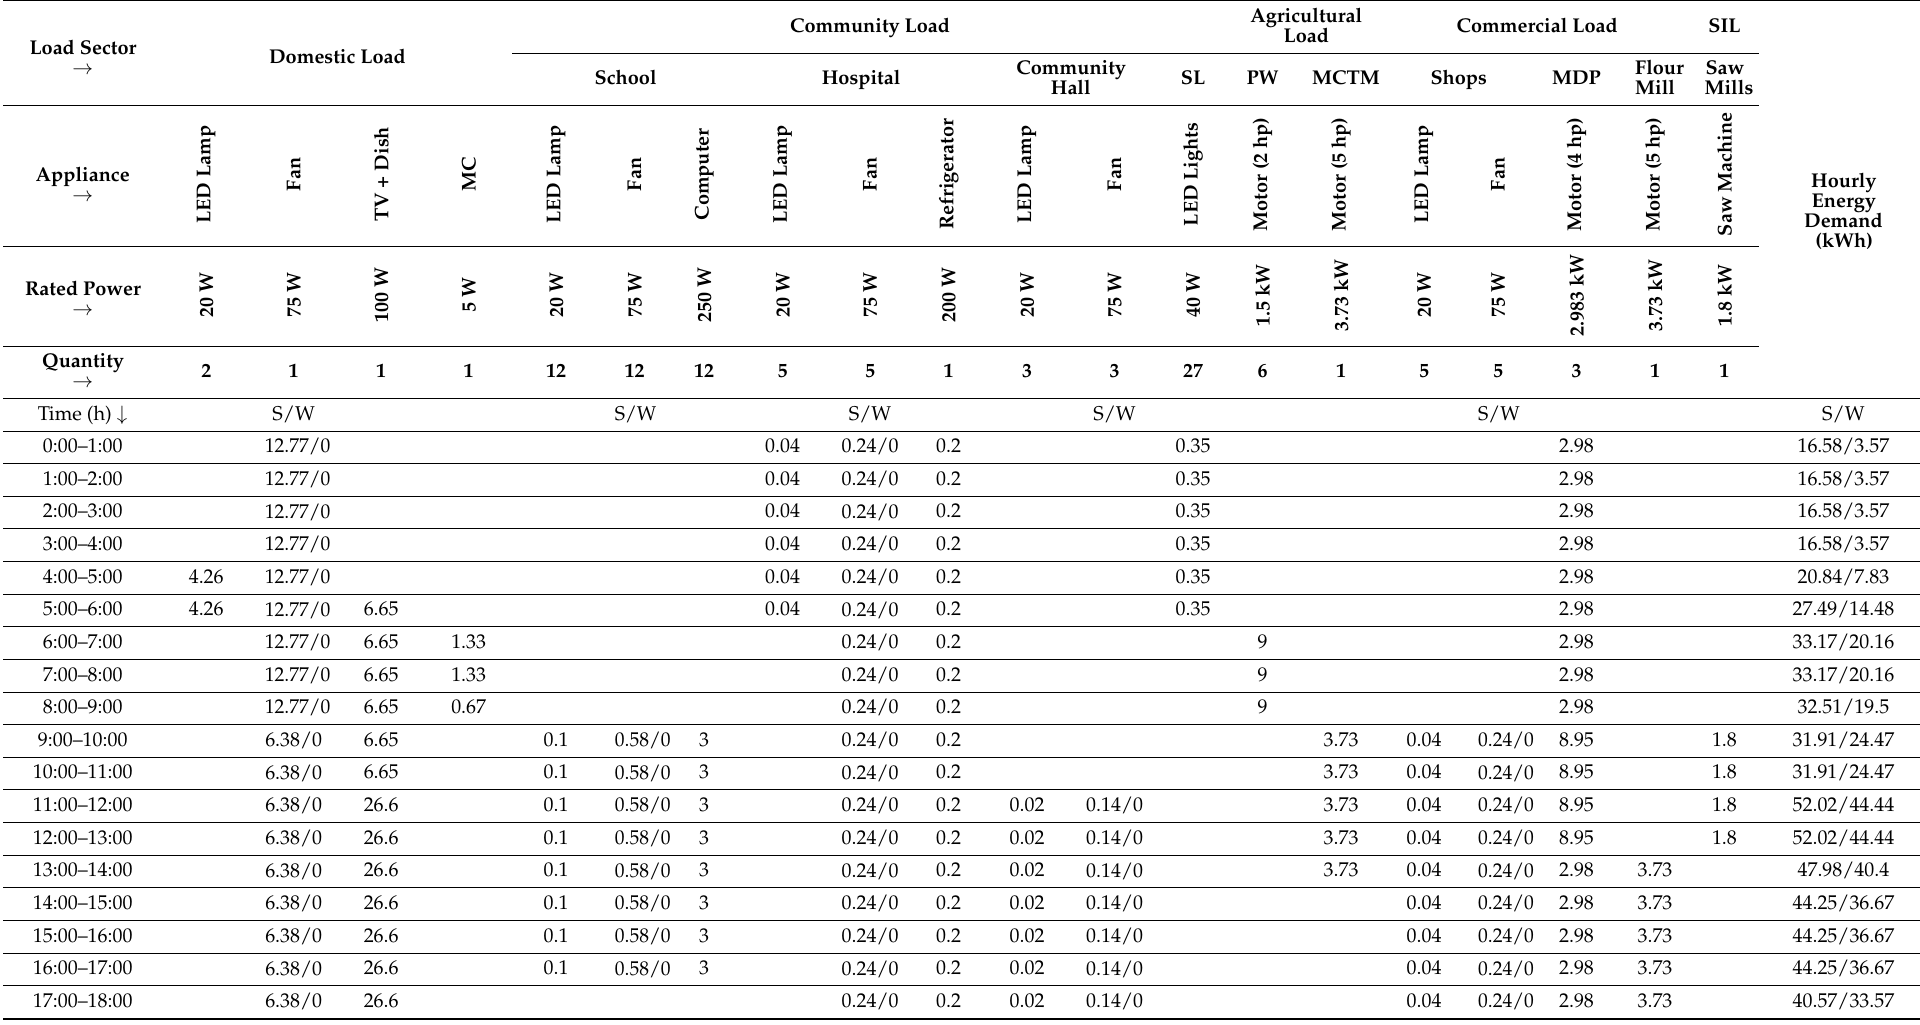
Table 3. LPRAHC-based scenario load demand for both winter and summer